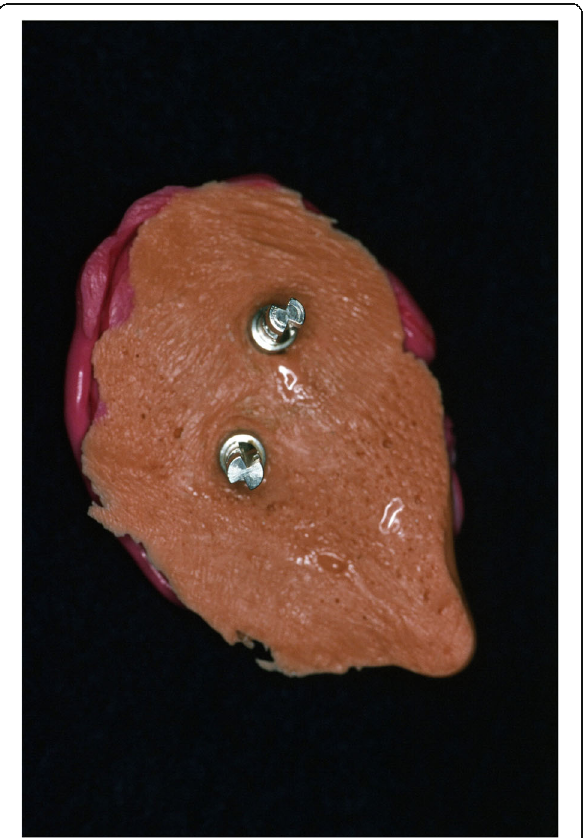
Fig. 4 Pickup of the impression copings in silicone Fig. 5 Abutment analogs connected to the